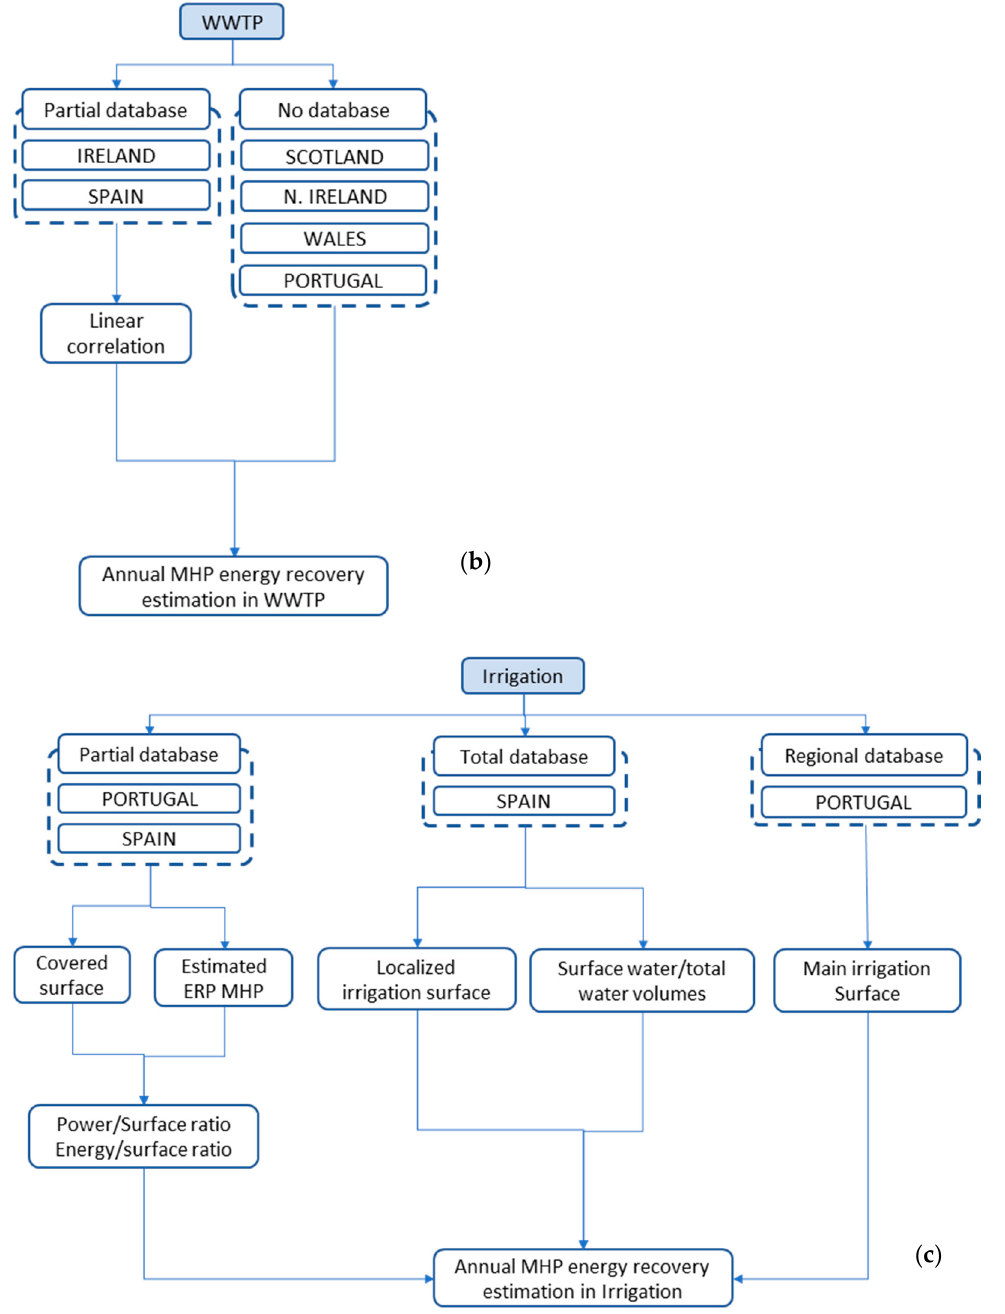
Figure 2. ( a ) Schematic representation of the methodology followed to estimate the MHP annual energy recovery potential (ERP) in the drinking water sector. ( b ) Schematic representation of the methodology followed to estimate the MHP annual energy recovery potential (ERP) in the wastewater sector. ( c ) Schematic representation of the methodology followed to estimate the MHP annual energy recovery potential (ERP) in the irrigation sector.